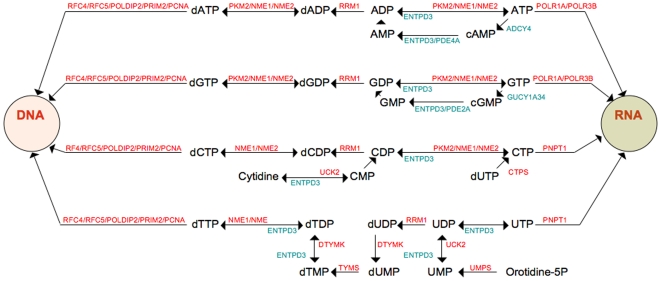
Schematic presentation of the results of differential expression of the purine and pyrimidine pathways in tumour versus parietal pleura (P<0.05).Genes encoding proteins responsible for DNA and RNA synthesis and recycling of purines and pyrimidines are overexpressed (red), while genes having the opposite or regulating role (green) are down-regulated. Genes encoding de novo synthesis of adenosine, guanosine, thymidine, cytidine and uracil were not differentially expressed (not shown). This pattern may represent salvage pathways facilitating tumour growth. Up: CTPS = CTP synthase, DTYMK = deoxythymidylate kinase, TYMS = thymidylate synthase, UCK2 = uridine-cytidine kinase, UMPS = uridine monophosphate synthase, POLR1A = polymerase (RNA) I polypeptide A, POLR3B; polymerase (RNA) III (DNA directed) polypeptide B, NME = non-metastatic cells 1, NME2 = non-metastatic cells 2, PKM2 = pyruvate kinase, muscle, PRIM2A = primase, DNA, polypeptide 2, PNPT1 = polyribonucleotide nucleotidyltransferase 1, PCNA = proliferating cell nuclear antigen, RRM1 = ribonucleotide reductase M1. Down: ADCY4 = adenylate cyclase 4, GUCY1A3 = guanylate cyclase 1, soluble, alpha 3, PDE2A = phosphodiesterase 2A, cGMP-stimulated, PDE4A = phosphodiesterase 4A, cAMP-specific, PDE5A = phosphodiesterase 5A, cGMP-specific, ENTPD3 = ectonucleoside triphosphate diphosphohydrolase 3.